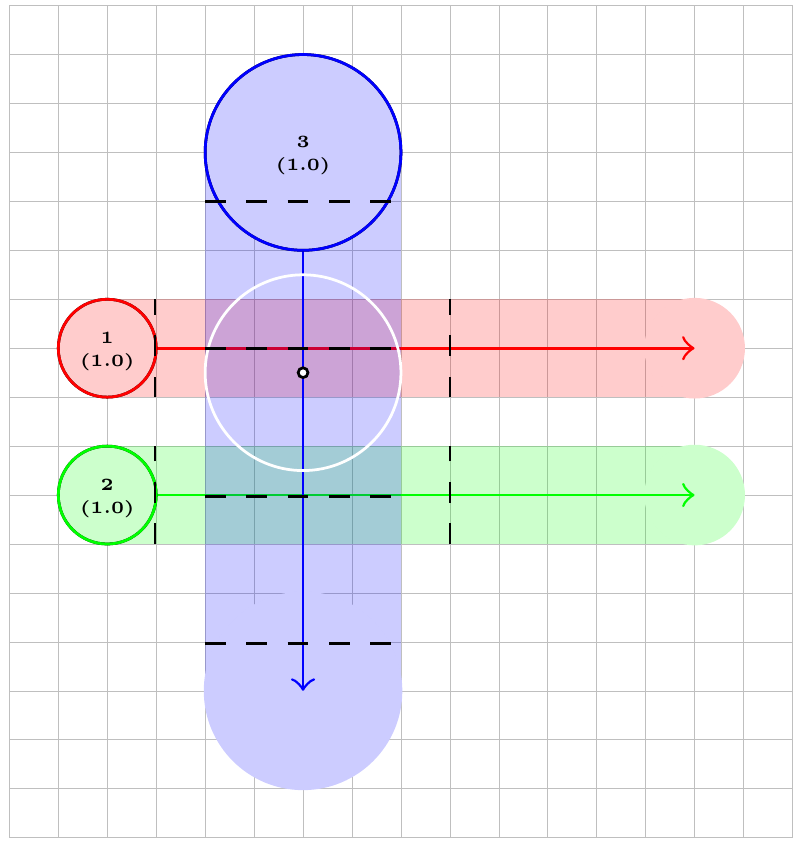
Figure 2. Exemplary instance for 3 robots. The white dot and circle denote a position and disk range somewhere along the path of robot 3. The dashed lines represent the borders of sectors (which will be explained further